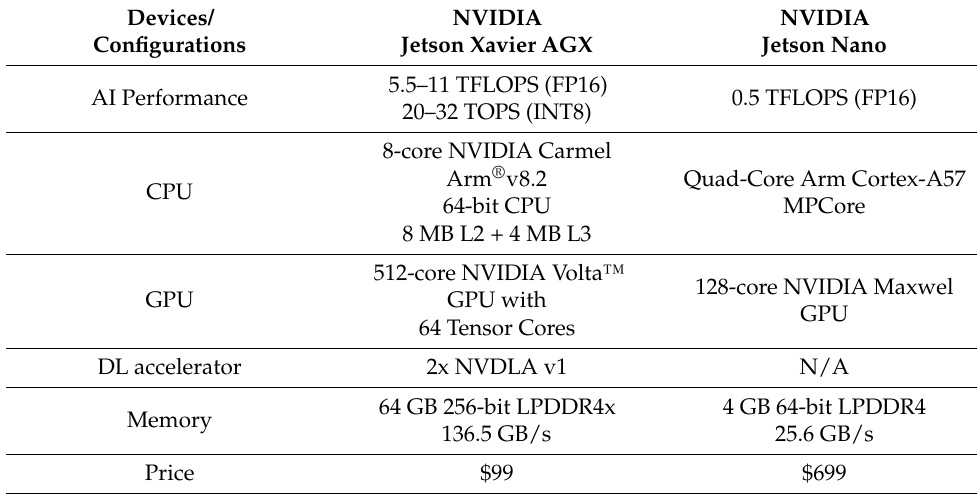
Table 4. Deployment devises configuration.